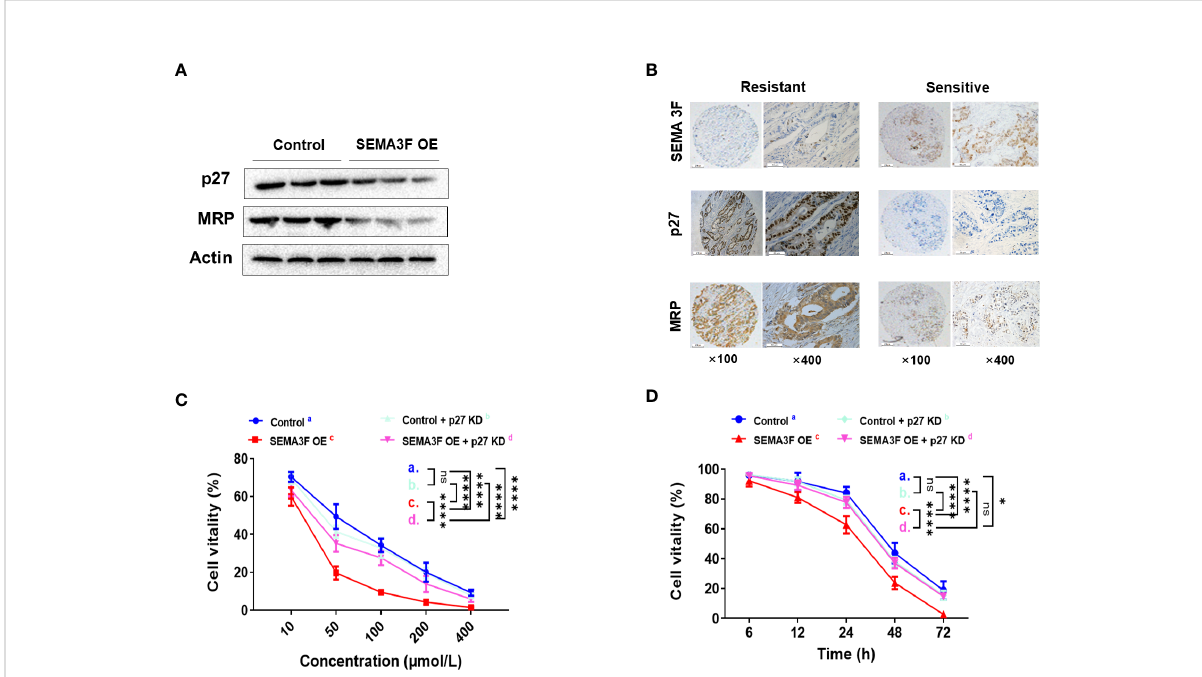
FIGURE 4 SEMA3F enhances the chemotherapeutic sensitivity of CRC cells to 5-Fu by downregulating p27. (A) Western blotting was used to assess the nuclear expression levels of p27 and MRP in the SEMA3F OE and control groups. (B) Immunohistochemical staining of SEMA3F, p27 and MRP in CRC patient tissues sensitive or resistant to chemotherapy. (C) The viability rates of LoVo cells with different expression levels of p27 and SEMA3F after treatment with 5-Fu at various concentrations (10, 50, 100, 200 and 400 m mol/L) are shown (****P<0.0001). (D) The survival curves of LoVo cells expressing different levels of p27 and SEMA3F after treatment with 5-Fu (200 m mol/L) for 72 h are shown (*P<0.05, ****P<0.0001). ns= Not Statistically Signi fi cant